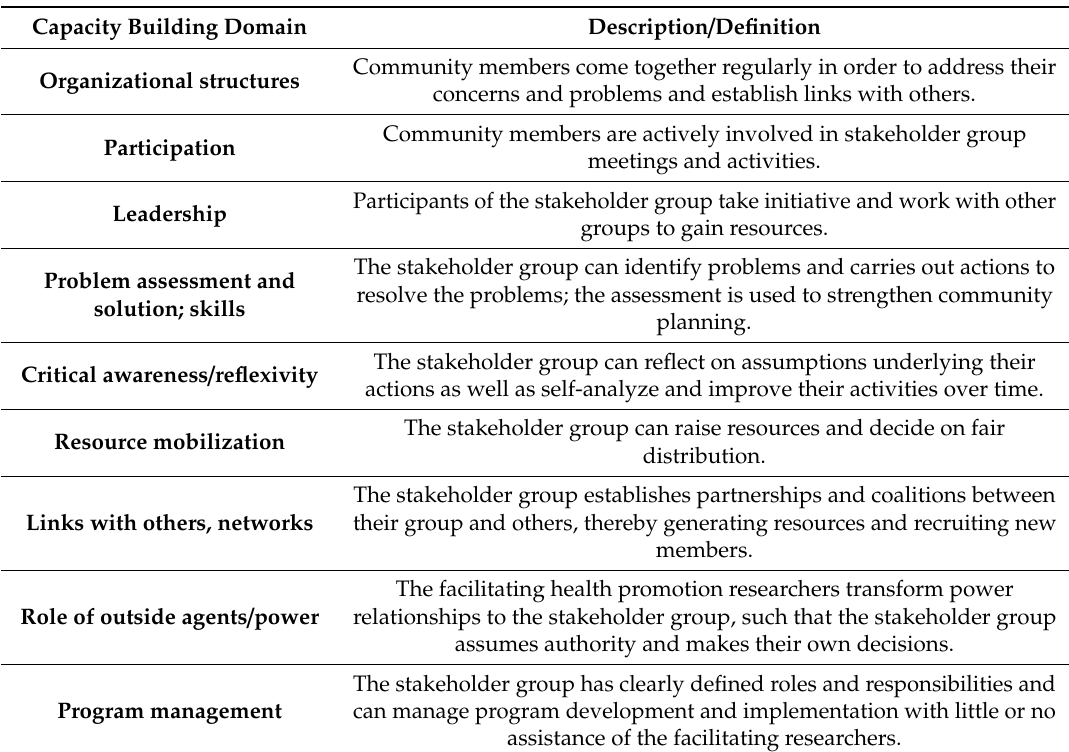
Table 1. Domains of capacity building used for